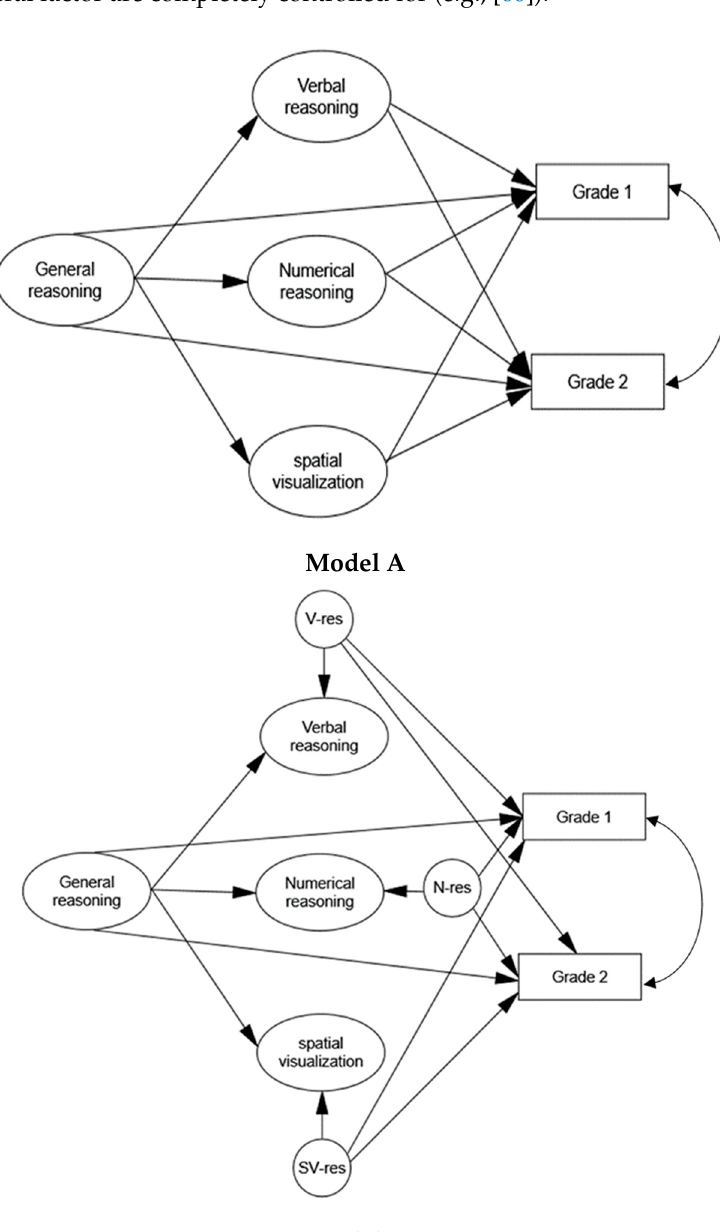
Figure 4. ( Top ) Model for predicting grades with general and specific abilities. ( Bottom ) Model for predicting grades with a general factor and the residuals of specific abilities. V-res = residual of verbal reasoning; N-res = residual of numerical reasoning; SV-res = residual of spatial visualization.